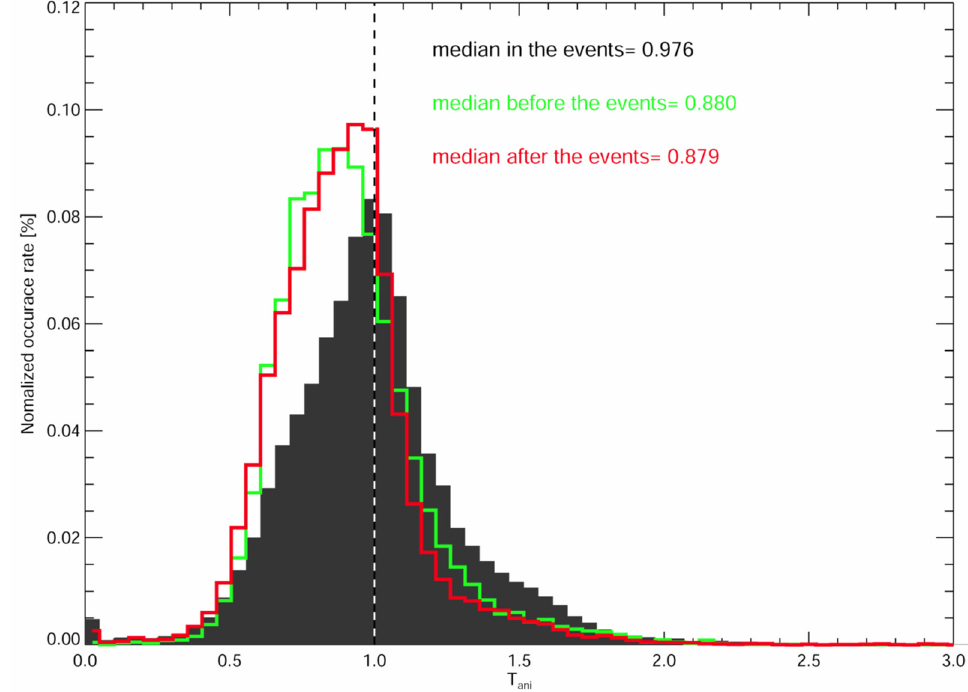
Figure 6. Histograms of T ANI of all observations. The format and colors are the same as in Figure 4.